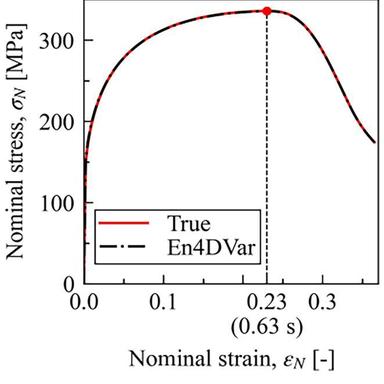
Nominal stress σN–nominal strain εN curves obtained from the virtual experiment (i.e., the true SS curve) and results of the simulation using the optimal parameters estimated by En4DVar.